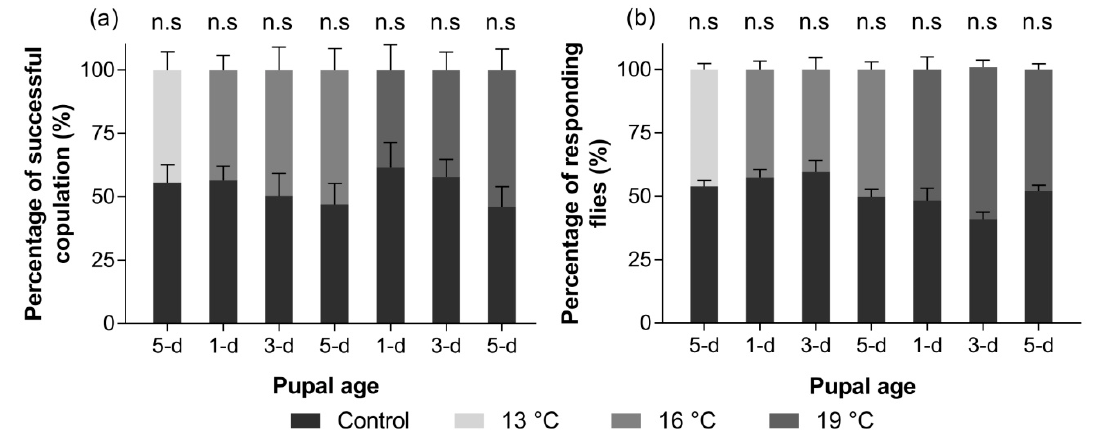
Figure 2. Mating competitiveness (mean ± SE) in the laboratory ( a ) and response to methyl eugenol (ME) in a field cage ( b ) of male B. dorsalis (GSS) after pupal cold storage.